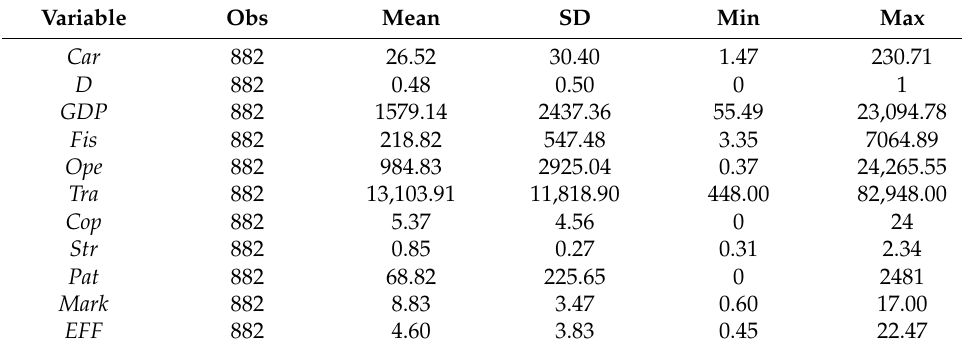
Table 2. Summary of